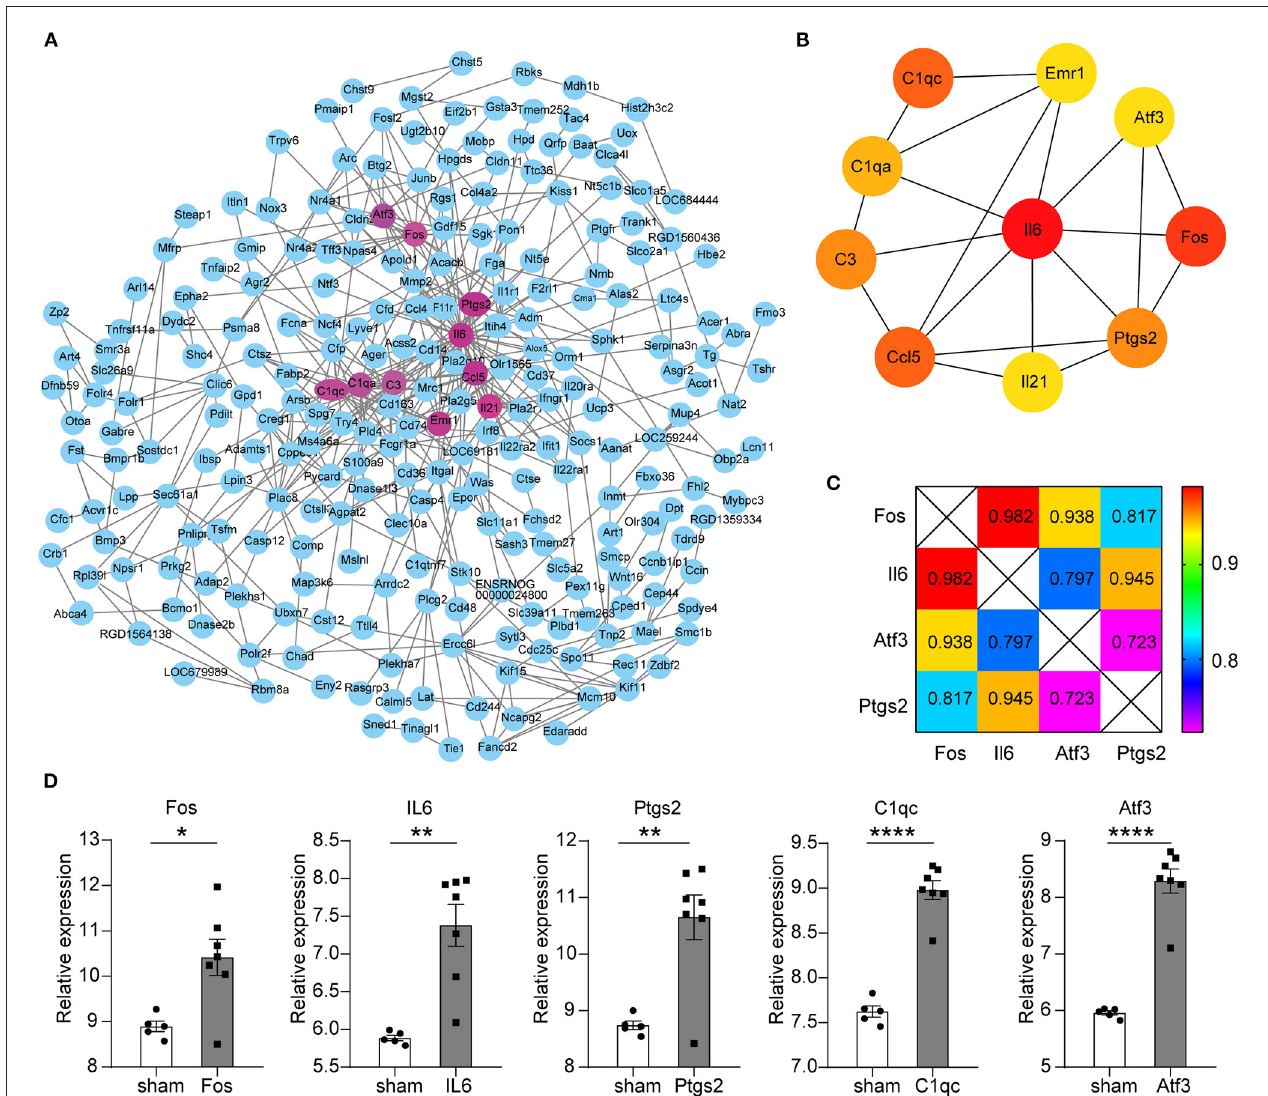
FIGURE 2 | Protein–protein interaction (PPI) network construction for key modules and screening of key genes. (A) The circle represents the protein corresponding to the gene, and the wiring represents the interaction. The circles with mauve represent the top 10 key genes in the degree scores. (B) Circles represent genes, lines represent interactions, and color represents degree scores, of which red was the highest score. (C) The number is the PPI interaction score of differential genes; the different colors indicate different scores. Total score: Fos = 2.737, Il6 = 2.724, Atf3 = 2.458, Ptgs2 = 2.485. (D) Five differential gene expression levels in GSE97537. The abscissa represents different groups; the ordinate shows the relative gene expression levels, and the error bar is the mean ± SEM, * p < 0.05, ** p < 0.01, **** p <